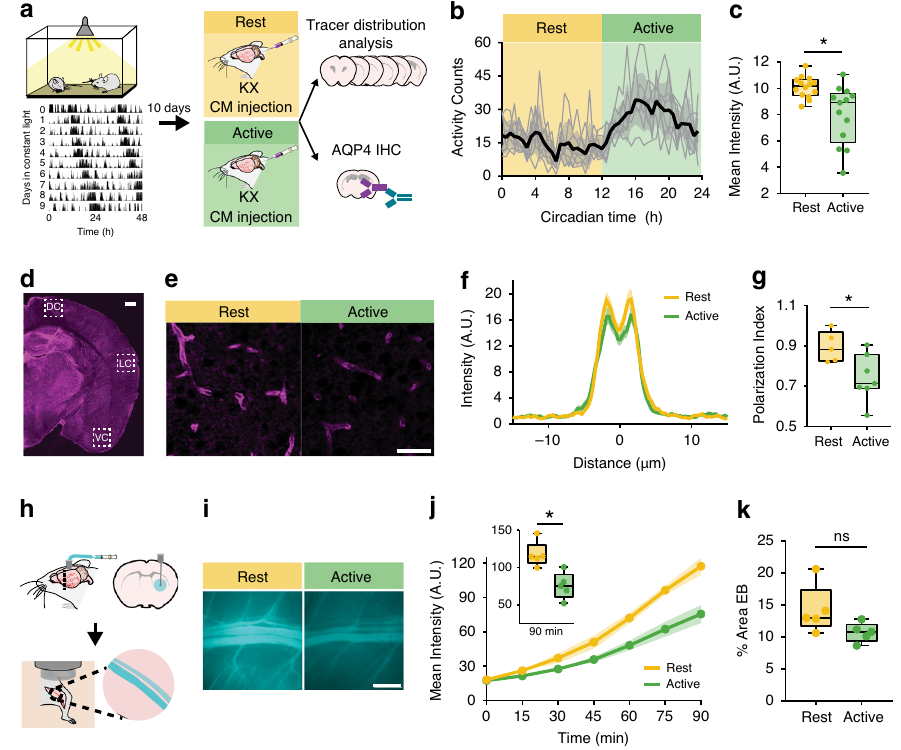
Fig. 4 Differences in the glymphatic system persist in constant light. a Experimental outline with representative double-plotted actogram of two animals in constant light (LL). Black tick marks: beam-breaks. b Average activity pro fi le of animals housed in LL for 10 days. Black line and gray error bars: group mean ± SEM, thin gray lines: individual cage activity pro fi les. Yellow: rest phase, green: active phase. Circadian time (CT) 12 is activity onset. n = 7 cages, 14 mice. c Boxplot of mean intensity (arbitrary units, A.U.) from ex vivo tissue fl uorescence. Mann – Whitney test: p = 0.0033, n = 13 mice rest, 14 mice active. d Representative slice of AQP4 staining. White boxes indicate areas of dorsal, lateral, and ventral cortex (DC, LC, VC, respectively) for AQP4 localization quanti fi cation. White scale bar: 500 µ m. e Representative ×40 images stained for AQP4 (magenta). White scale bar: 50 µ m. f Average intensity of AQP4 centered on vasculature in cortex during the rest (yellow, for e , g : n = 5 mice, 45 vessels) and active (green, for f , g : n = 7 mice, 63 vessels) phase, mean ± SEM is indicated by shading (SEM) around thick line (mean). g Boxplot of polarization index for staining in ventral, dorsal and lateral cortex. Polarization index equals peak fl uorescence minus 10 µ m baseline. All values normalized to the highest signal for better visualization. Two- sided t test: p = 0.0288. h Schematic of clearance experiment. i Representative Cy5 images of the femoral vein 90 min after evans blue (EB) injection during rest (yellow) or active (green) phases. White scale bar: 1 mm. j Mean intensity over time. Thick lines: group means, outlines: SEM, individual points: image acquisition. Inset: boxplot of fl uorescence at 90 min. Two-sided t test: p = 0.0051. Time 0 is tracer infusion start. For j , k : n = 5 mice per group. k Boxplot of percent area EB during rest and active phases. All boxplots minima: minimum value, maxima: maximum value, center: median, and quartiles: box and whiskers, individual animals: colored dots. Asterisk indicates p < 0.05; ns: not signi fi cant. Source data are provided as a Source Data fi ( t test: t (14) = 1.727, p = 0.1062). Thus, 10 days in LL does not